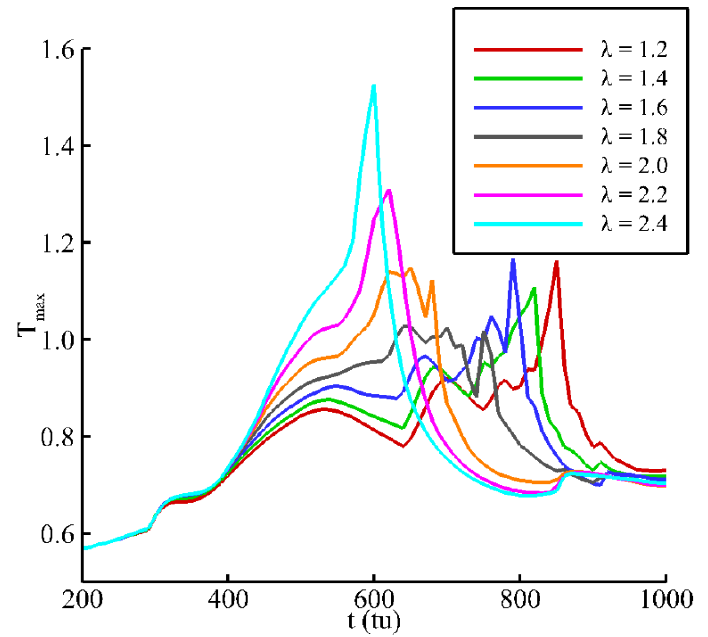
Figure 8. The evolution process of maximum temperature during the bubble collapse.